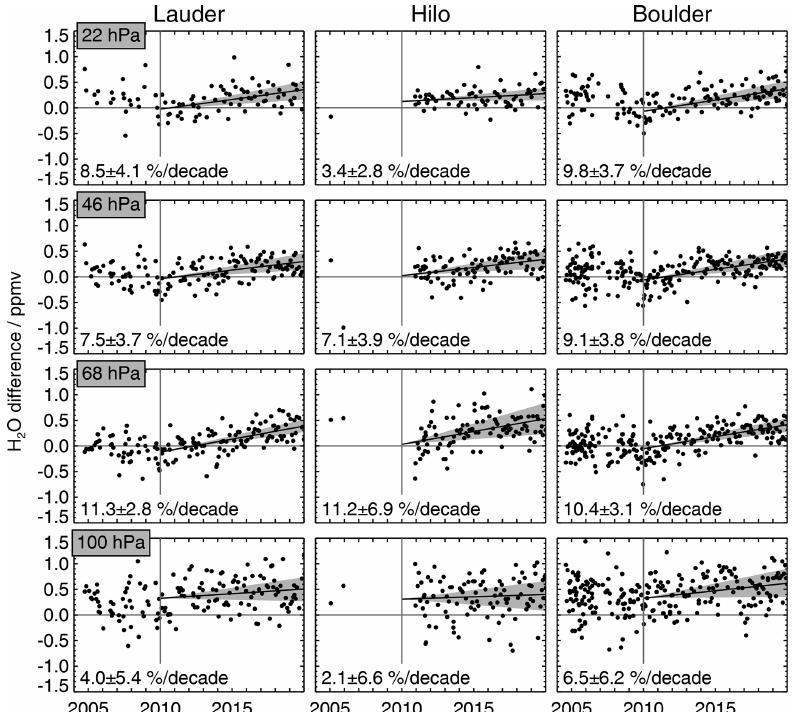
Figure 1. Time series of differences between MLS v4 water vapor and coincident frost point sonde measurements made from Lauder (45 ◦ S, 170 ◦ E, left), Hilo (20 ◦ N, 155 ◦ W, center), and Boulder (40 ◦ N, 105 ◦ W, right) at selected pressure levels (rows). Coincidence criteria are, as in Hurst et al. (2016), ± 2 ◦ latitude, ± 8 ◦ longitude, and ± 18h. Positive differences imply that MLS measures greater humidity than the in situ observation. Black lines show a linear fit to the post-2010 differences (with all points weighted equally). Gray shading shows the 95% confidence interval for the slope (from a block bootstrap resampling of year-long blocks of the fit residuals). Fitted drift rates are quoted in each panel, with uncertainties corresponding to the 2 σ spread of the bootstrap results. Comparisons at the intermediate vertical levels (not shown) indicate similar